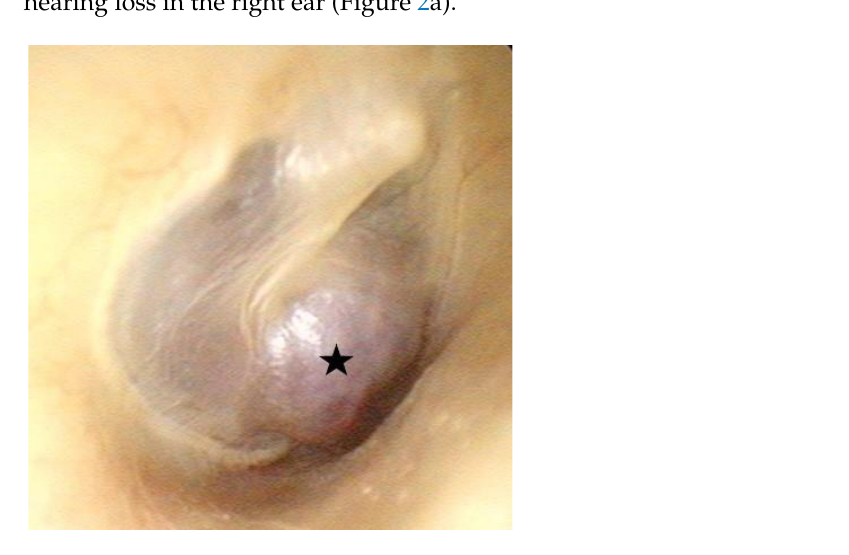
Figure 1. Otoscopy of right ear revealing a red retrotympanic mass (asterisk) causing pulsatile protrusion of the anteroinferior quadrant of the eardrum.